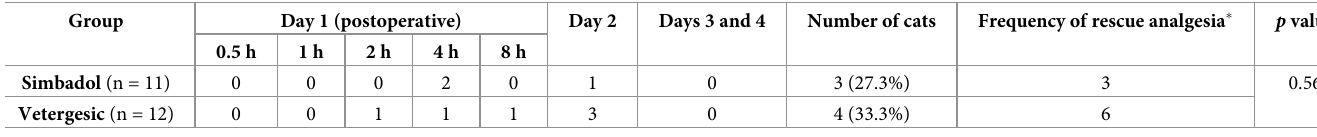
Table 6. Number of cats receiving rescue analgesia at each time point during the study.